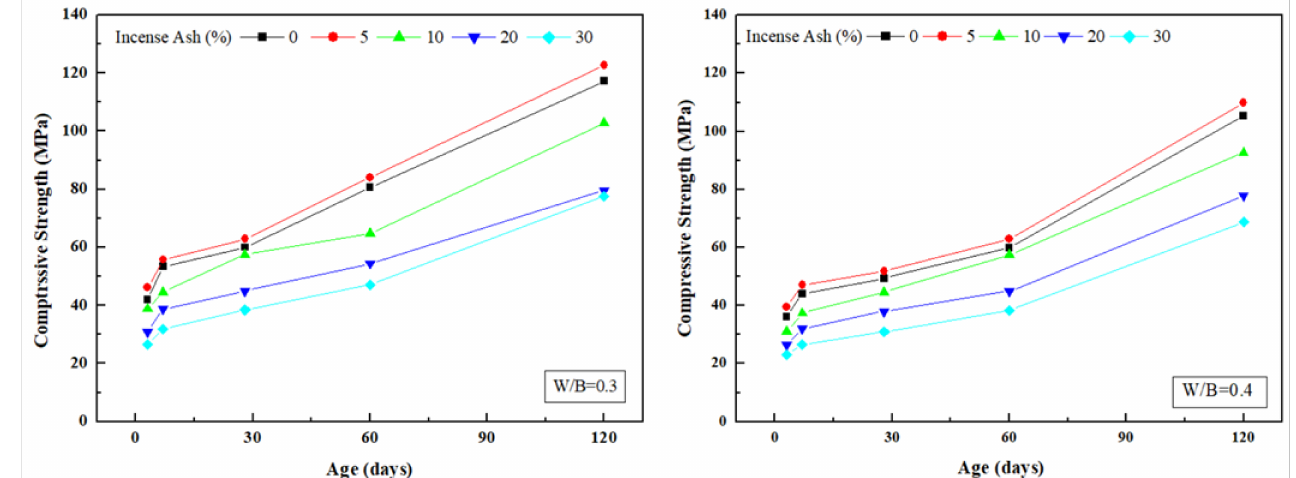
Figure 3. Compressive strength developments of incense ash paste (75 ◦